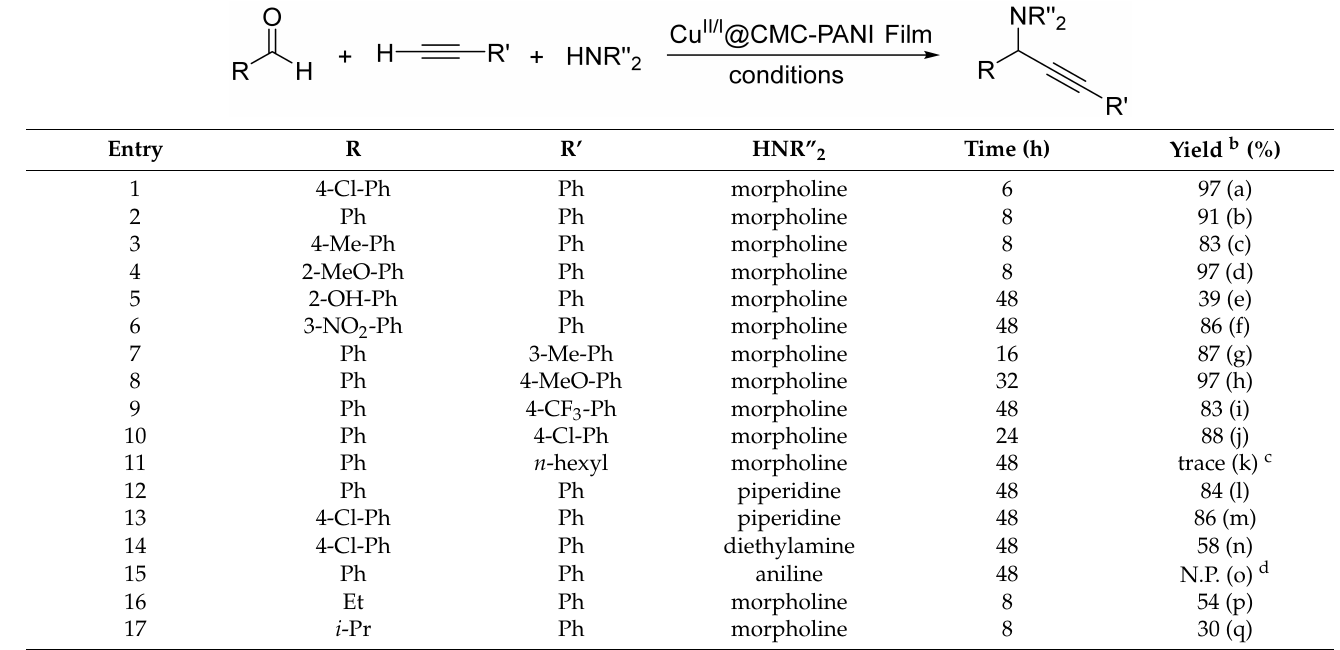
Table 2. A 3 coupling reactions catalyzed by Cu II/I @CMC-PANI film to synthesize a variety of propargylamines a